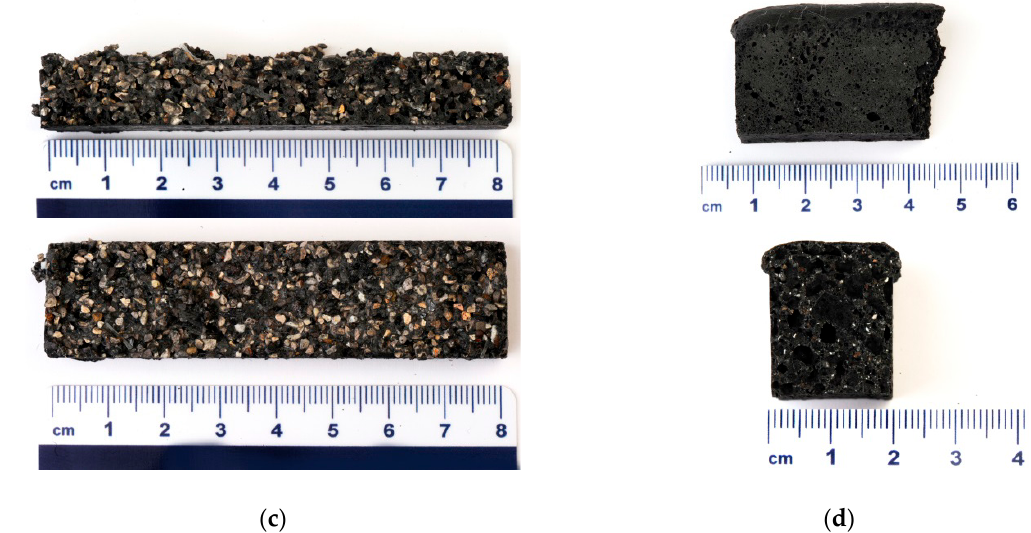
Figure 6. Photographs of RM sieved ( a ) above 4 mm, ( b ) between 2 mm and 4 mm, ( c ) between 1 mm and 2 mm and ( d ) below 1 mm.